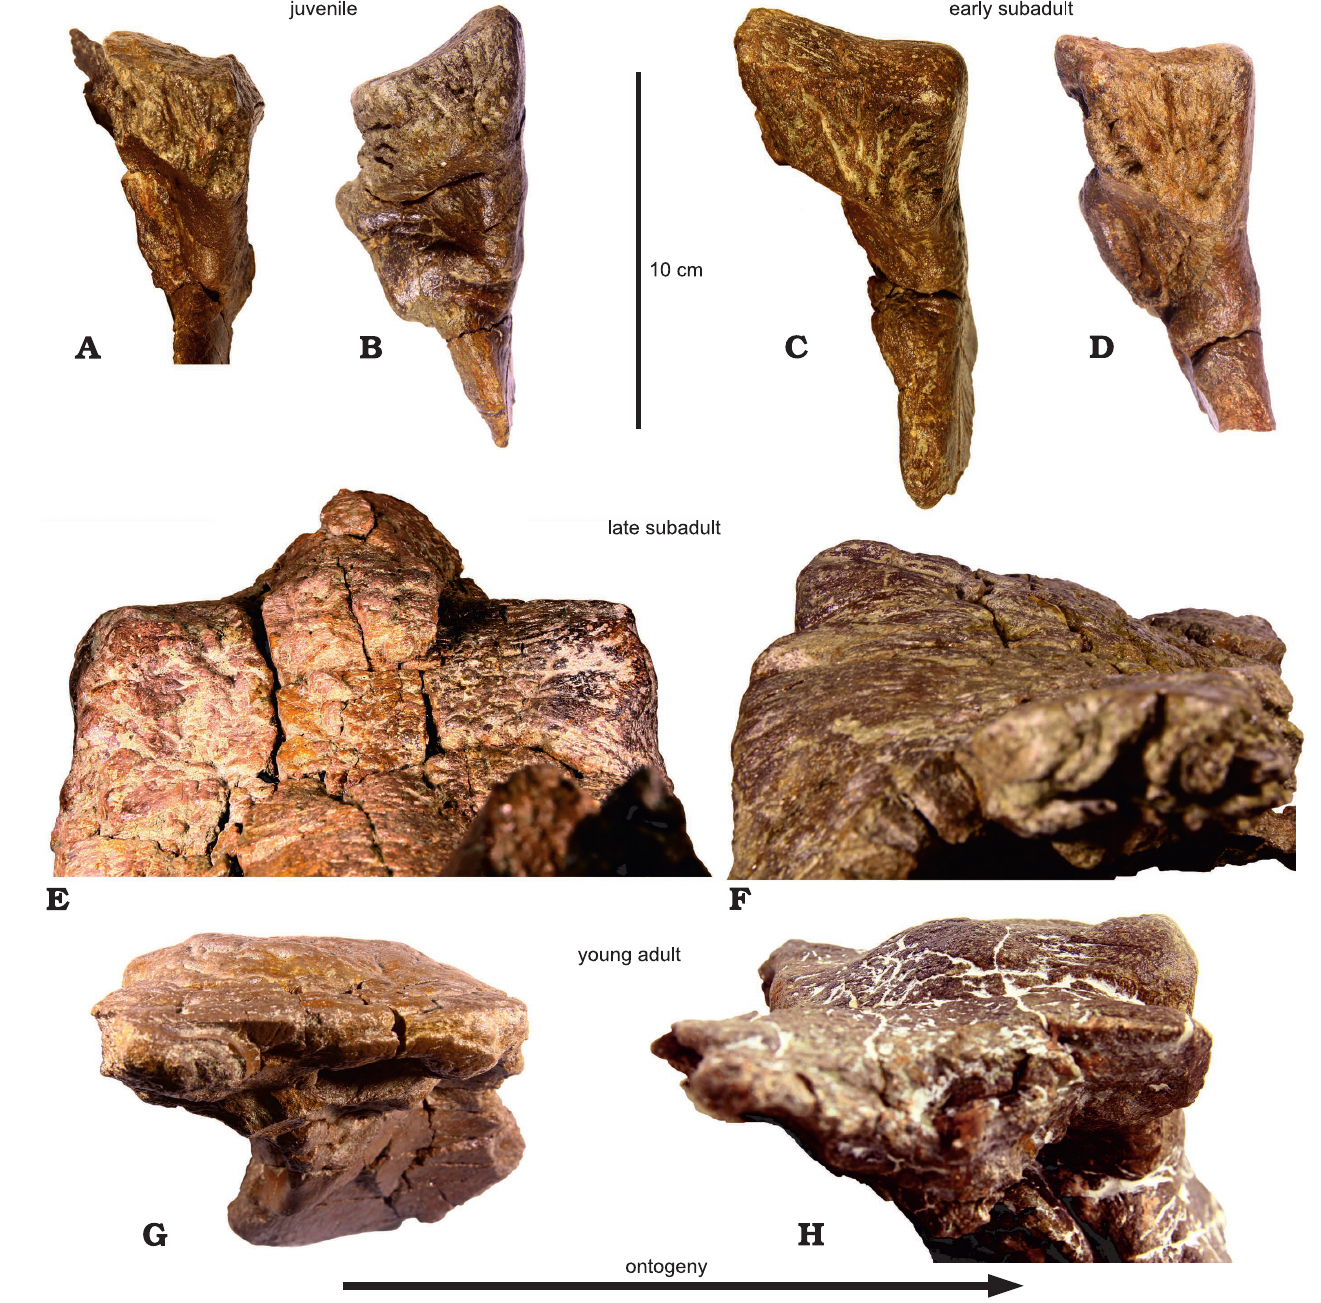
Fig. 6. Ontogenetic series of supraorbital ornamentation of Einiosaurus procurvicornis Sampson, 1995 from the Campanian Canyon Bonebed, Two Medicine Formation (TM-046), Montana, USA. A , B . Juvenile, MOR 456 8-10-87-20 ( A ) and MOR 456 8-8-87-19 ( B ). C , D . Early subadult, MOR 456 8-9-7-3 ( C ) and MOR 456 2020-C-1 ( D ). E , F . Late subadult, MOR 456 8-8-87-1 ( E ) and MOR 456 8-23-87 ( F ). G , H . Young adult, MOR 456 2020-C-2 ( G ) and MOR 456 8-9-6-1 ( H ). B and D are mirrored. All specimens in anterior view, lateral is to the right in A–D, G, H; E, entire skull width; F, lateral is to the